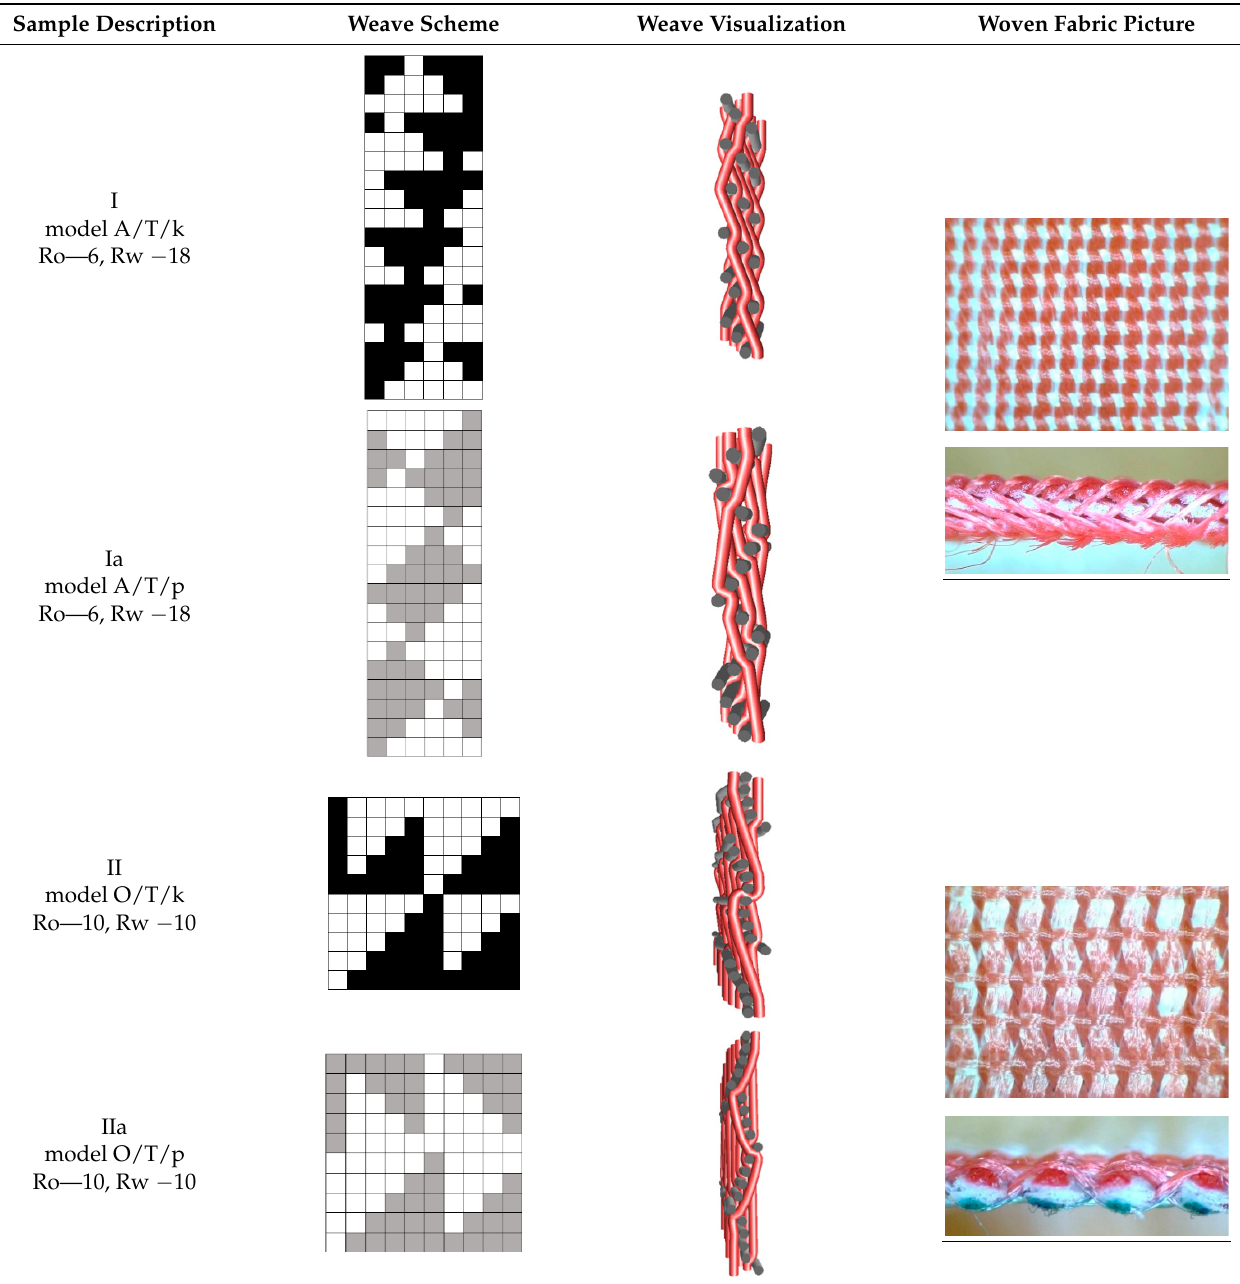
Table 1. The modified weaves of MLW (multilayer woven fabrics) and their cross sections along the warp. Sample Description